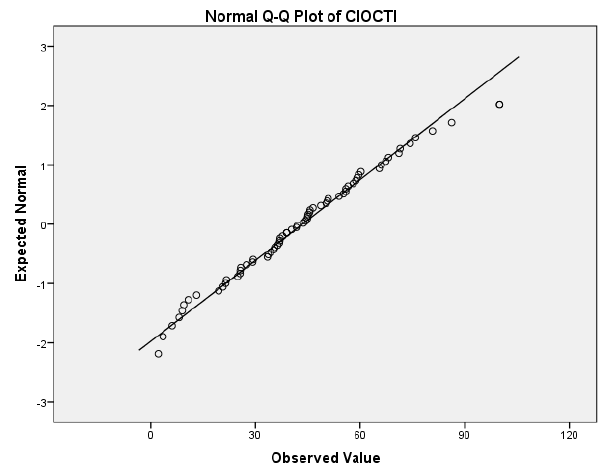
Figure 2. Normal Q-Q plot of CIOICTI.